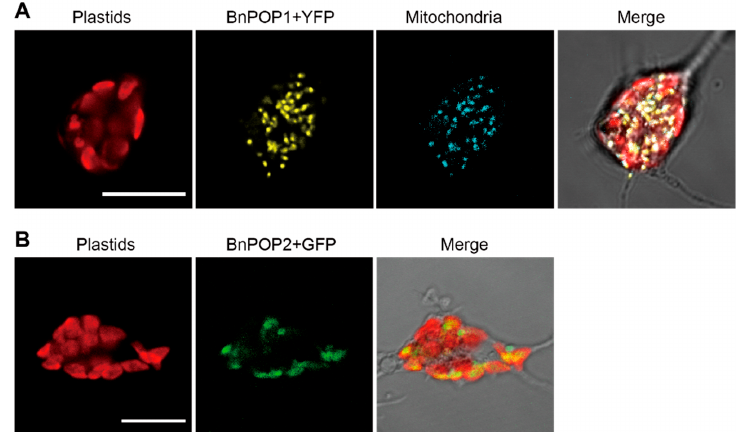
Figure 2. Subcellular localization of BnPOP1 and BnPOP2. Green/yellow/cyan fluorescent protein (GFP/YFP/CFP) fusion proteins were expressed in the chlorarachniophyte, Amorphochlora amoebiformis . The red color is the chlorophyll-autofluorescence, and the yellow and green signal represent localization of BnPOP1 ( A ) and BnPOP2 ( B ), respectively. Mitochondria were labelled by CFP fused with the mitochondria-targeted histidine tRNA synthetase. The scale bars are 10 µm. Biomolecules 2019 , 9 , x FOR PEER REVIEW